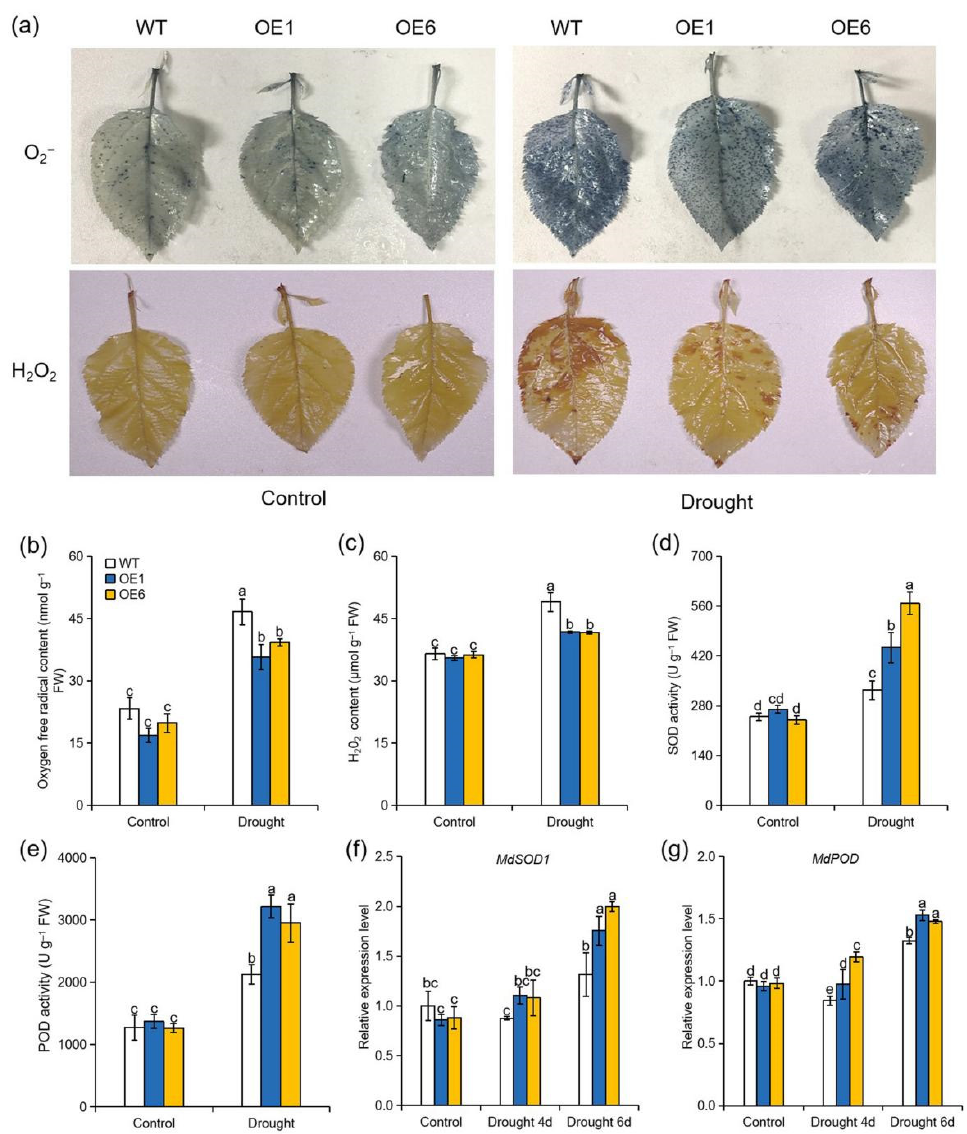
Figure 3. Effect of MdATG8i overexpression in apple on ROS scavenging under drought conditions. ( a ) Detection of O 2 − and H 2 O 2 by NBT and DAB staining, ( b ) O 2 − concentrations, ( c ) H 2 O 2 concen- trations, ( d ) SOD activity, and ( e ) POD activity in the leaves of WT and MdATG8i OE plants. Changes in the expression levels of ( f ) MdSOD1 and ( g ) MdPOD after drought stress. The data are presented as means ± SD of three replicates. Values with different letters are significantly different ( p < 0.05, Tukey’s multiple range